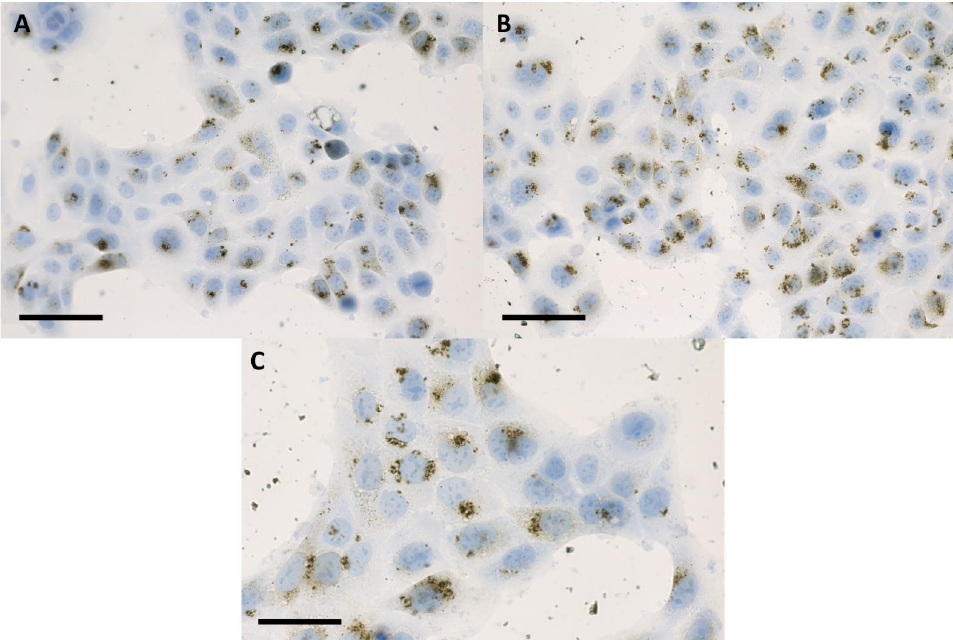
Figure 3. Bright-field microscopy images of human keratinocytes (HaCaT) cells at 24 h following 16 h of incubation with 100 µ g/mL ( A ), and 200 µ g/mL ( B ) IONP DOX ; blue hematoxylin, dark brown IONP; the measure bar is 50 µ m; ( C ) detailed image of HaCaT cells at 24 h following 16 h of incubation with 200 µ g/mL IONP DOX ; the scale bar is 25 µ